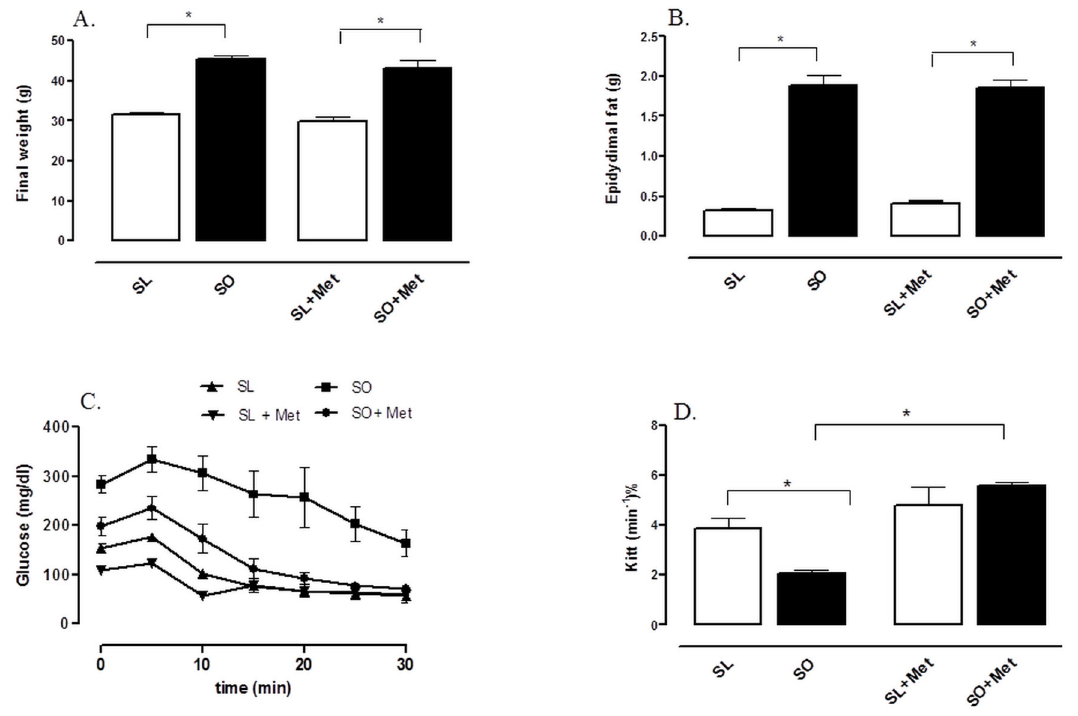
Figure 3. Effect of metformin treatment on body weight (A), epididymal fat mass (B), insulin tolerance test (C) and glucose decay rate (K ; %/min) (D). Male C57BL6/J mice were fed with either a standard chow diet (lean) or a high-fat diet (obese) during itt 10 weeks. Metformin (300mg/kg/dia) was given by gavage for the last two weeks. Each column represents the mean ± SEM (n = 6) for mice sensitized lean treated with vehicle (SL), sensitized obese treated with vehicle (SO), sensitized lean treated with metformin (SL + Met) and sensitized obese treated with metformin (SO + Met). *p<0.05 (SO vs SL); #p<0.05 (SO + Met vs